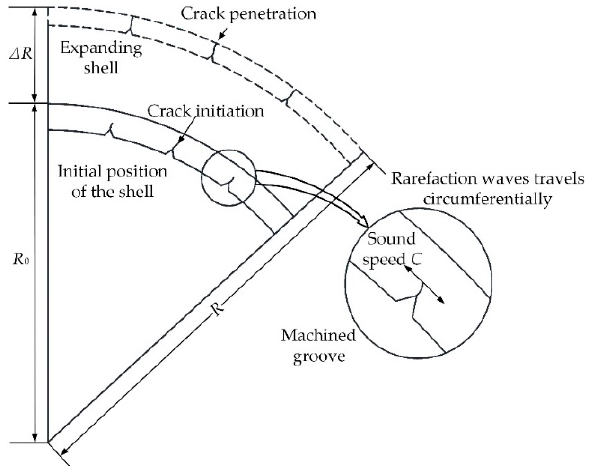
Figure 3. Crack propagation and expansion of a cylindrical shell subjected to internal explosive loading.